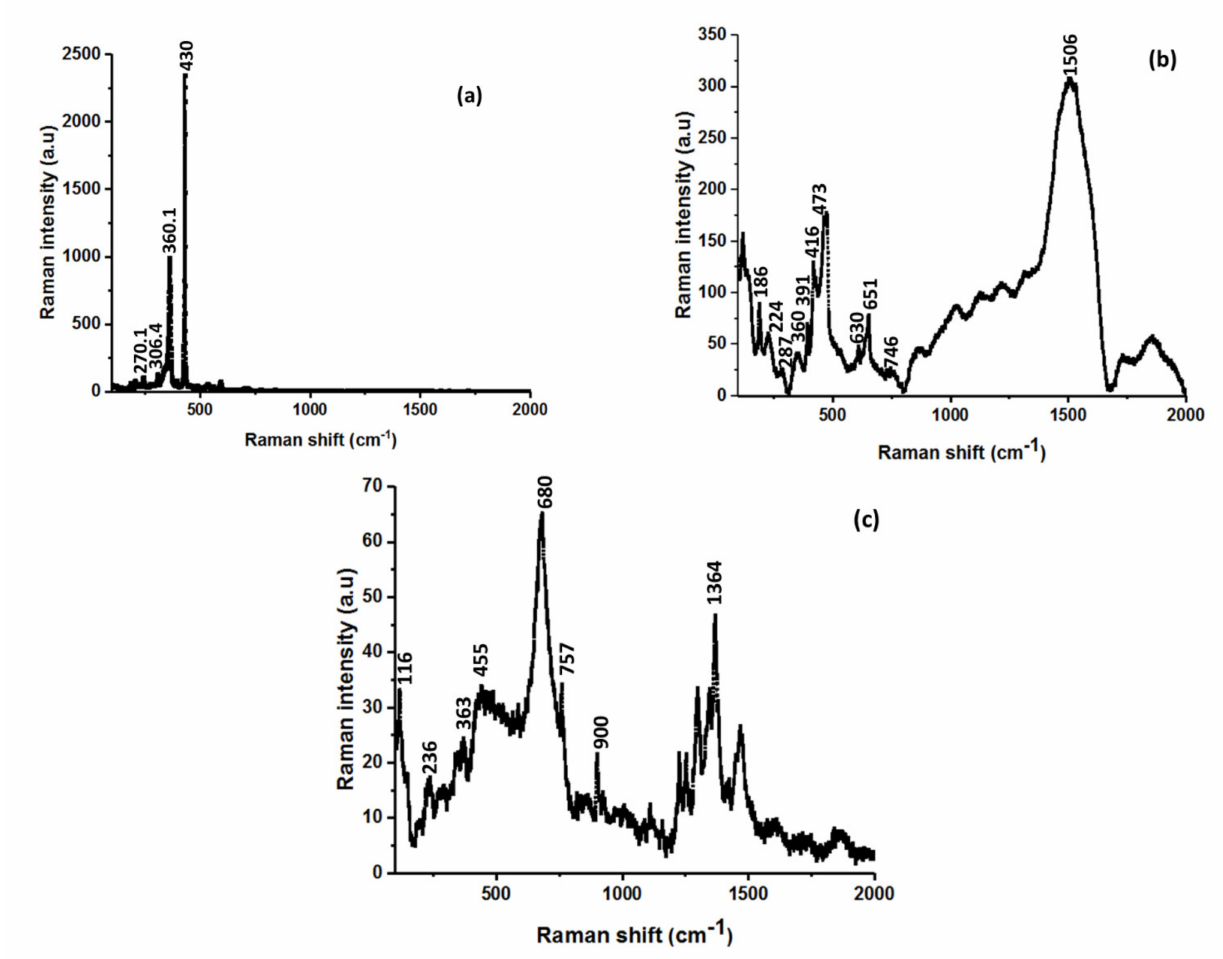
Figure 9. The Raman spectra of the wear scars on the stationary balls after the anti-wear tests. ( a ) WS 2- dispersed MO; ( b ) MoS 2 -dispersed MO; ( c ) PT-dispersed